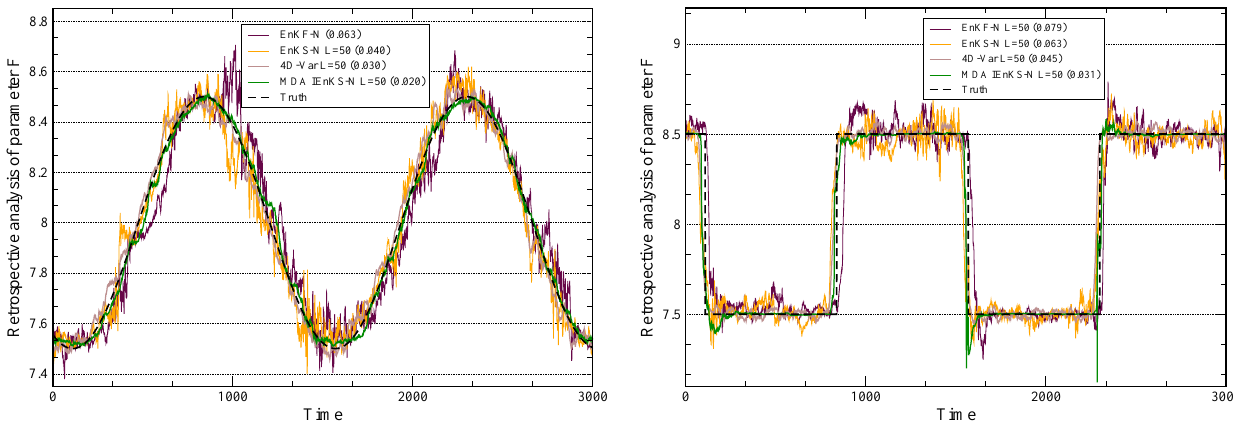
Fig. 11. Comparison of the retrospective analysis of F using the EnKF, the EnKS L = 50, 4D-Var L = 50 and the MDA IEnKS L = 50, when the truth (black dashed line) evolves as a sinusoid (left), and a step-wise function (right).